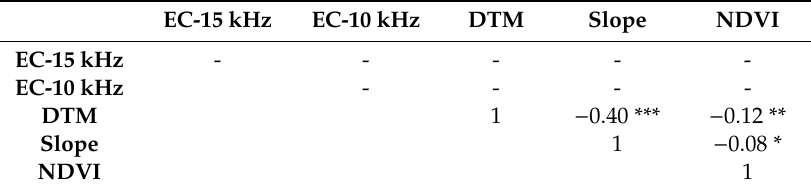
Table 3. Pearson’s correlation coe ffi cients among the variables used to delineate SSMZ, estimated considering the grid nodes with not valid EMI measurements (area ‘b’).